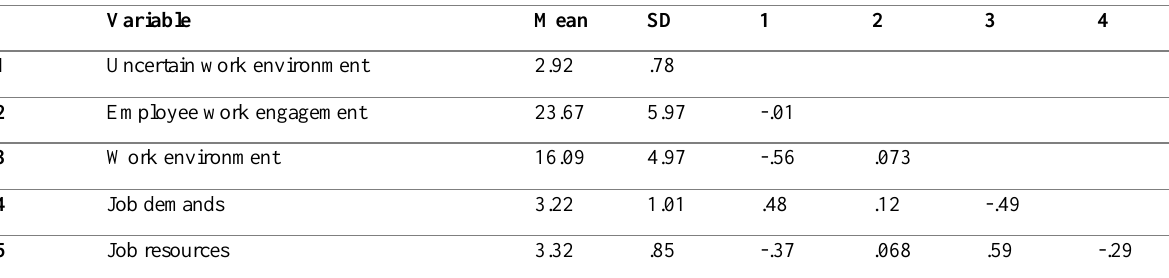
Table 1: Descriptive statistics for the study